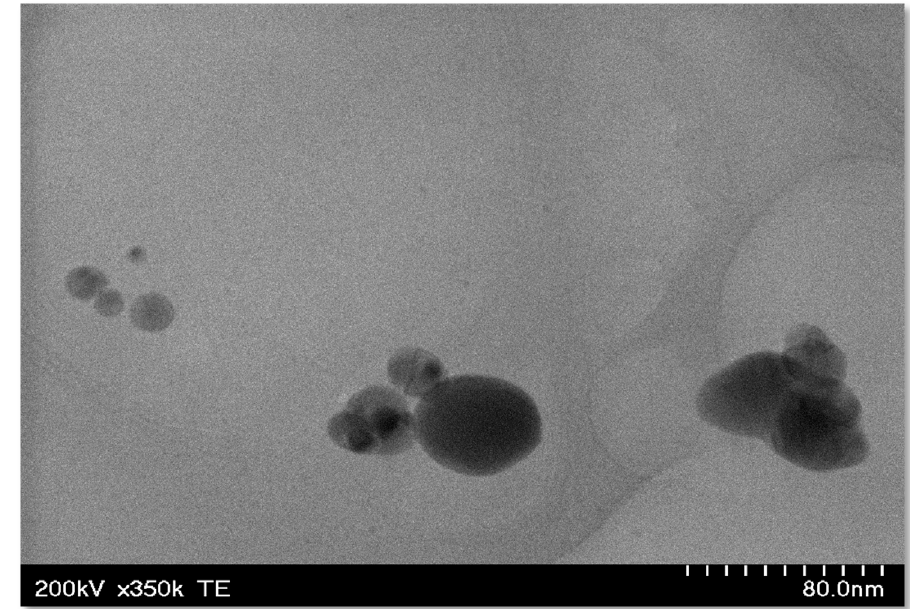
Figure 4. TEM images of Ag-FSE loaded CSNPs; where nanoparticles appeared globular in shape.